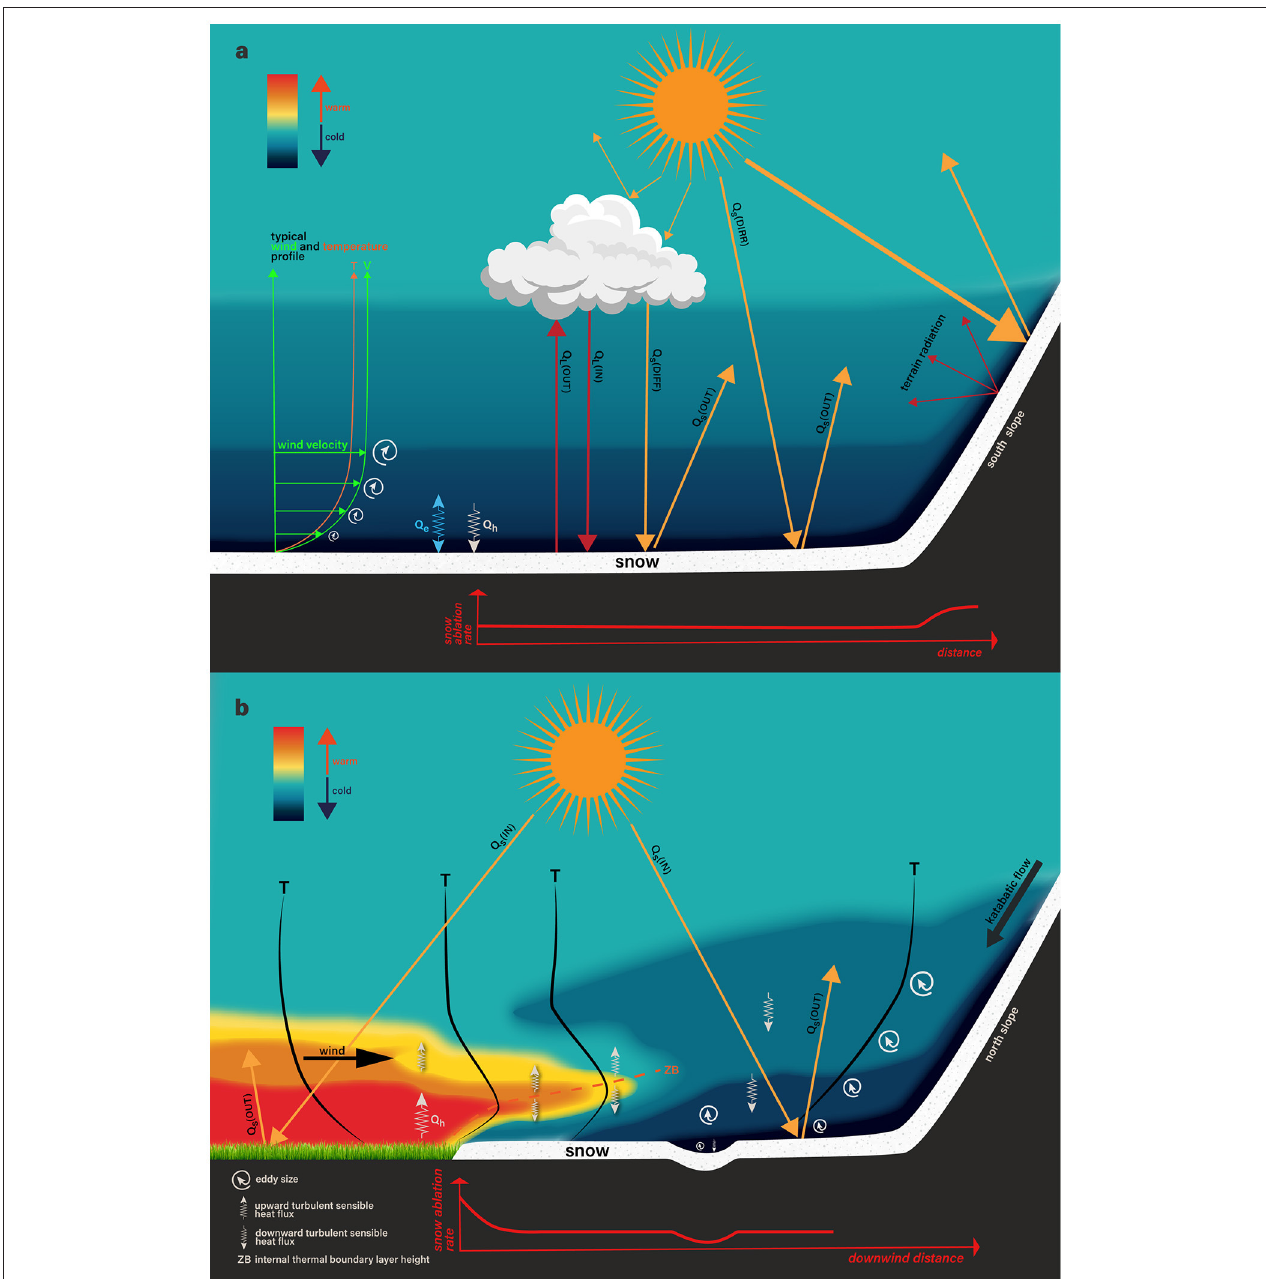
FIGURE 4 | Schematic description of energy exchange processes over a continuous snow cover (a) and additional processes acting over a patchy snow cover (b) . For the continuous snow cover incoming and outgoing longwave radiation (Q Lin , Q Lout ), incoming and reflected shortwave radiation (Q Sin , Q Sout ), terrain radiation, turbulent sensible and latent heat fluxes (Q h , Q e ) are presented. Typical profiles of wind, air temperatures and turbulence evolving during stable atmospheric conditions over snow are shown as well. For the patchy snow cover case, the boundary layer development (air temperature, turbulence, sensible heat fluxes) over snow induced by local advection of heat from snow-free toward the snow-covered area is